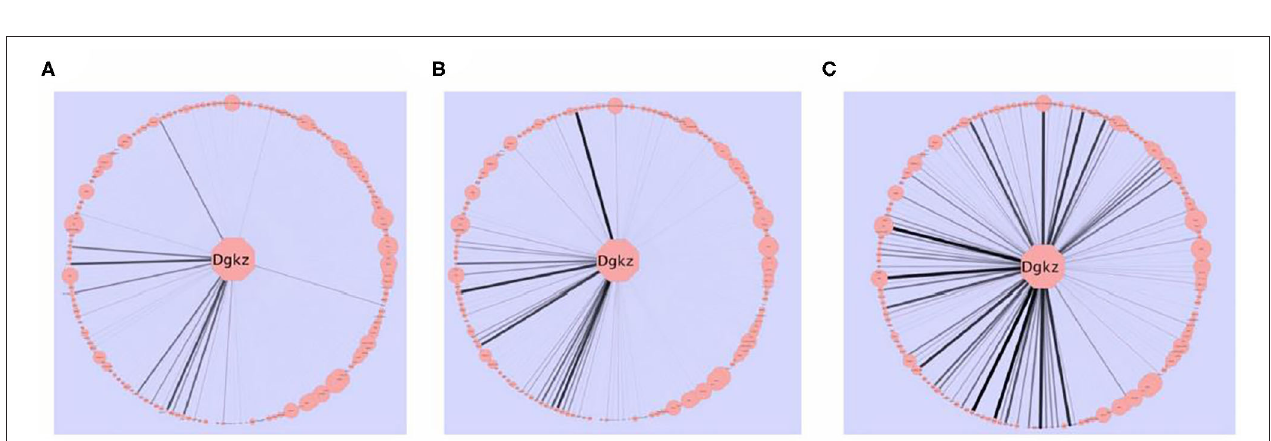
FIGURE 3 | The effects of selection on intra-modular connectivity for Dgkz . Dgkz is found in the “black” module. Edge thickness and opacity are proportional with network adjacency between Dgkz and other module transcripts. The intra-modular connectivity of the other module genes is reflected in the node size. (A) HS/NPT network connectivity. (B) HDID-2 network connectivity. (C) HDID-1 network connectivity. Note the more pronounced increase in connectivity in the HDID-1 as compared to the HDID-2 animals. Figure reprinted with permission from (52).